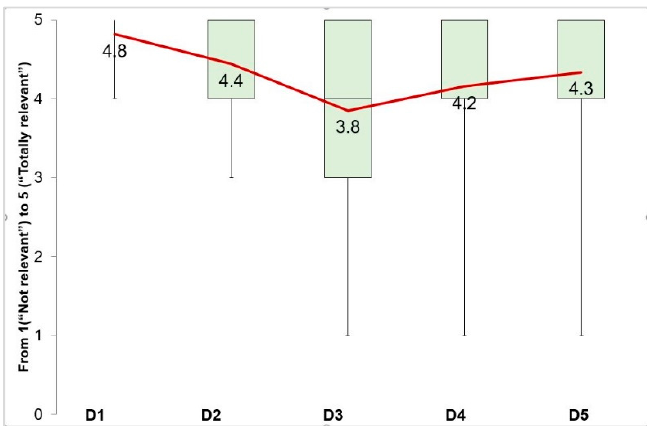
Figure 2. Relevance level (average and range) of global factors in the post-installation phase.